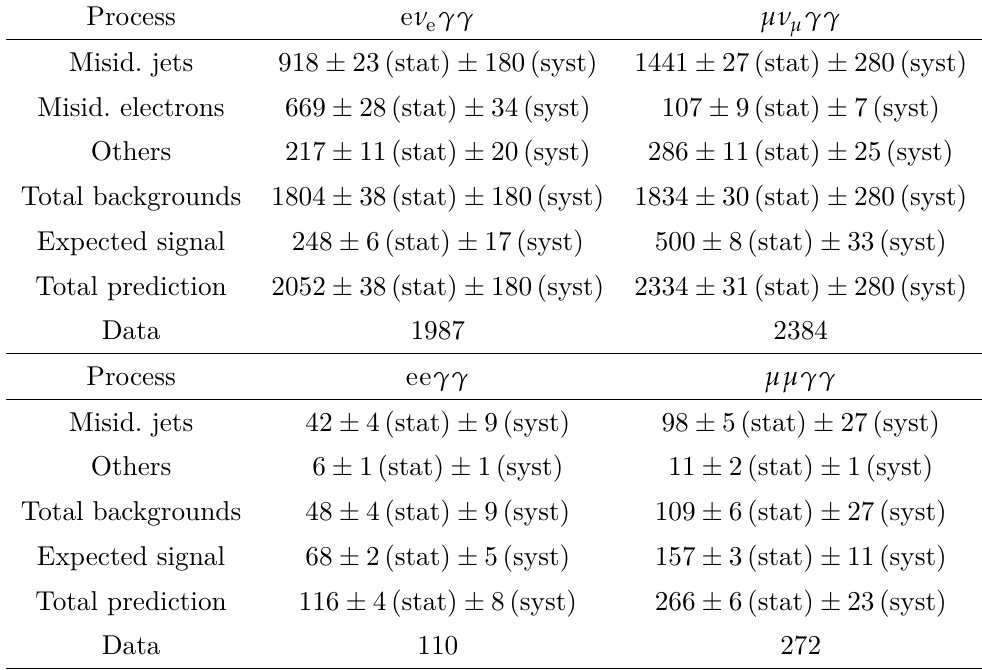
Table 2 . Summary of the pre-fit predicted and observed numbers of events for 137 fb − 1 for the W gg (upper table) and Z gg (lower table) selections in the electron and muon channels. The systematic uncertainties of the individual backgrounds and the total background are obtained by summing the contributions of different systematic uncertainties in quadrature. The statistical uncertainties are those related to the MC event samples and control region statistical